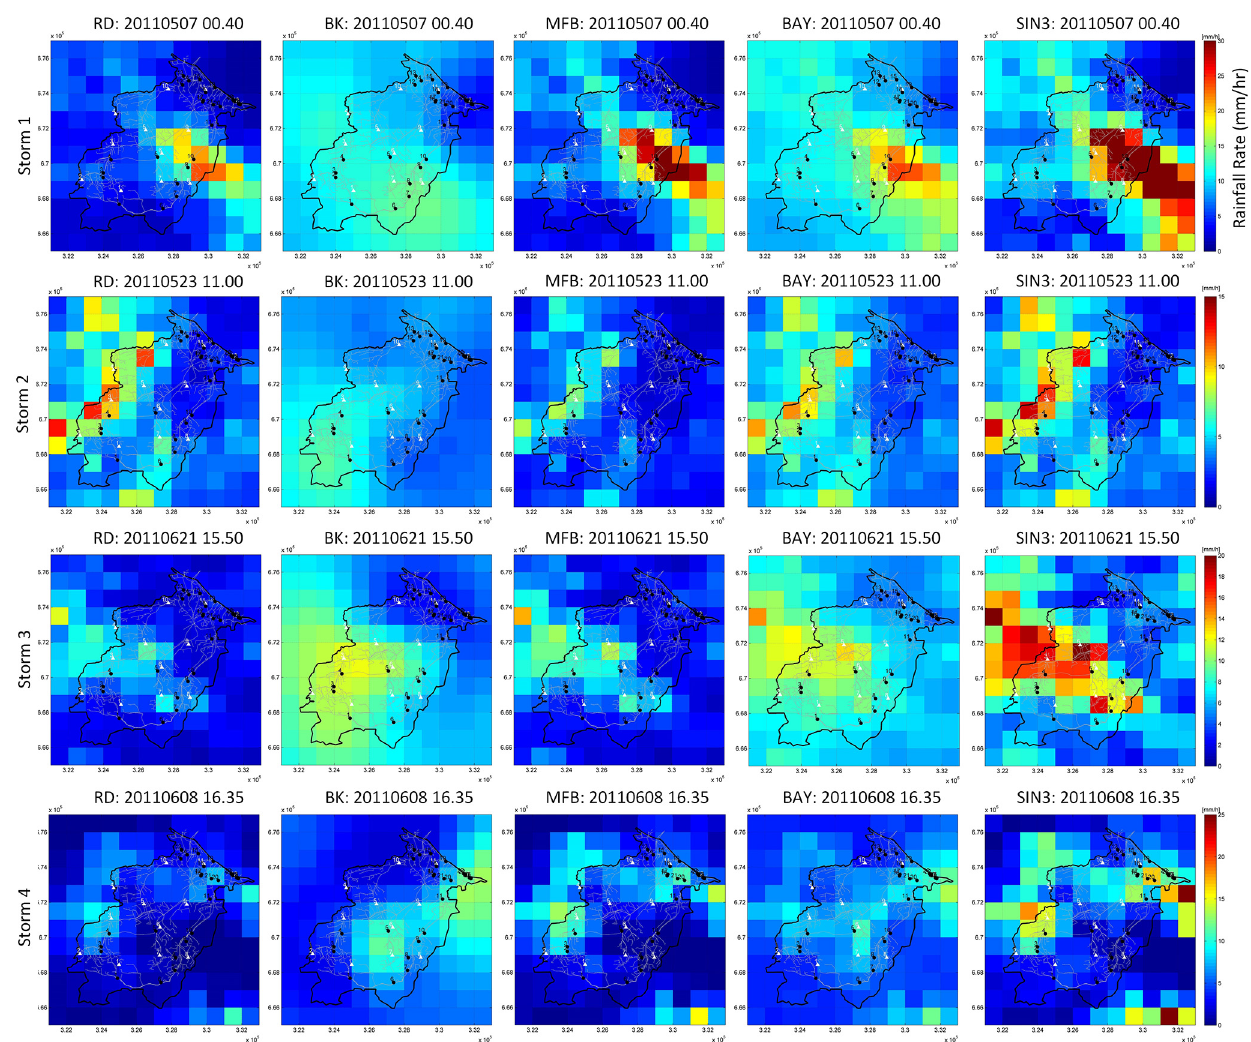
Figure 7. Snapshot images of the different spatial rainfall products at the time of peak areal intensity for Storms 1 (top panels) to 4 (bottom panels) over the Portobello catchment. From left to right panels: RD, BK, MFB, BAY and SIN3 (with singularity range [1, 3]) estimates. The black polygon indicates the boundary of the Portobello catchment, and the black and white markers respectively represent the location of flow and rain